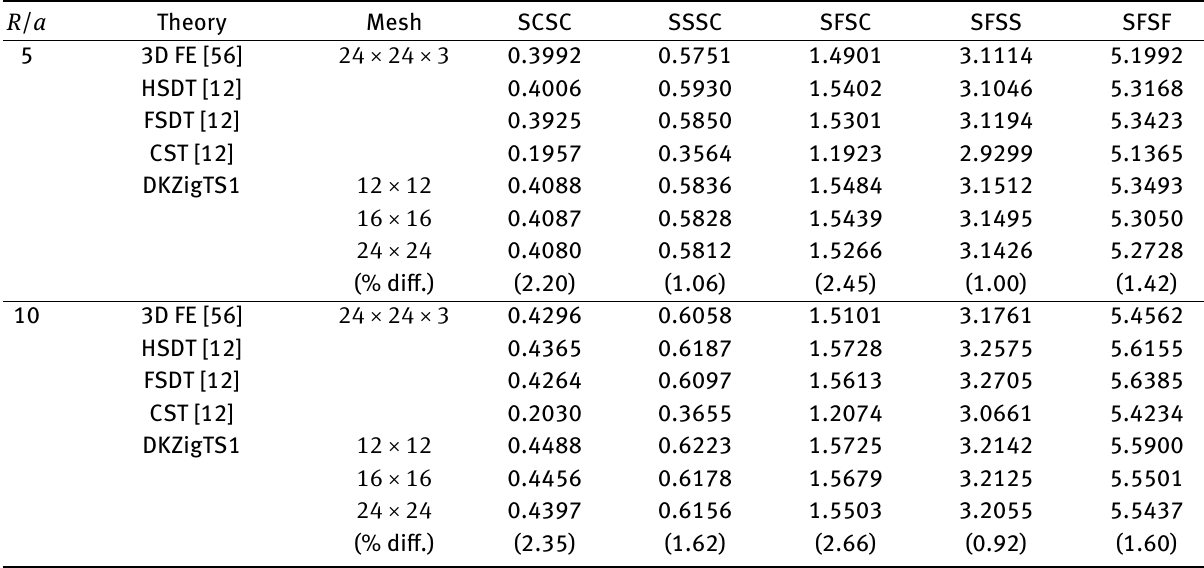
Table 12: Non-dimensionalised central deflection for a composite spherical shell panel ’F’ of varying boundary condition with b / a = 1 , h / a = 0.1 under sinusoidally distributed